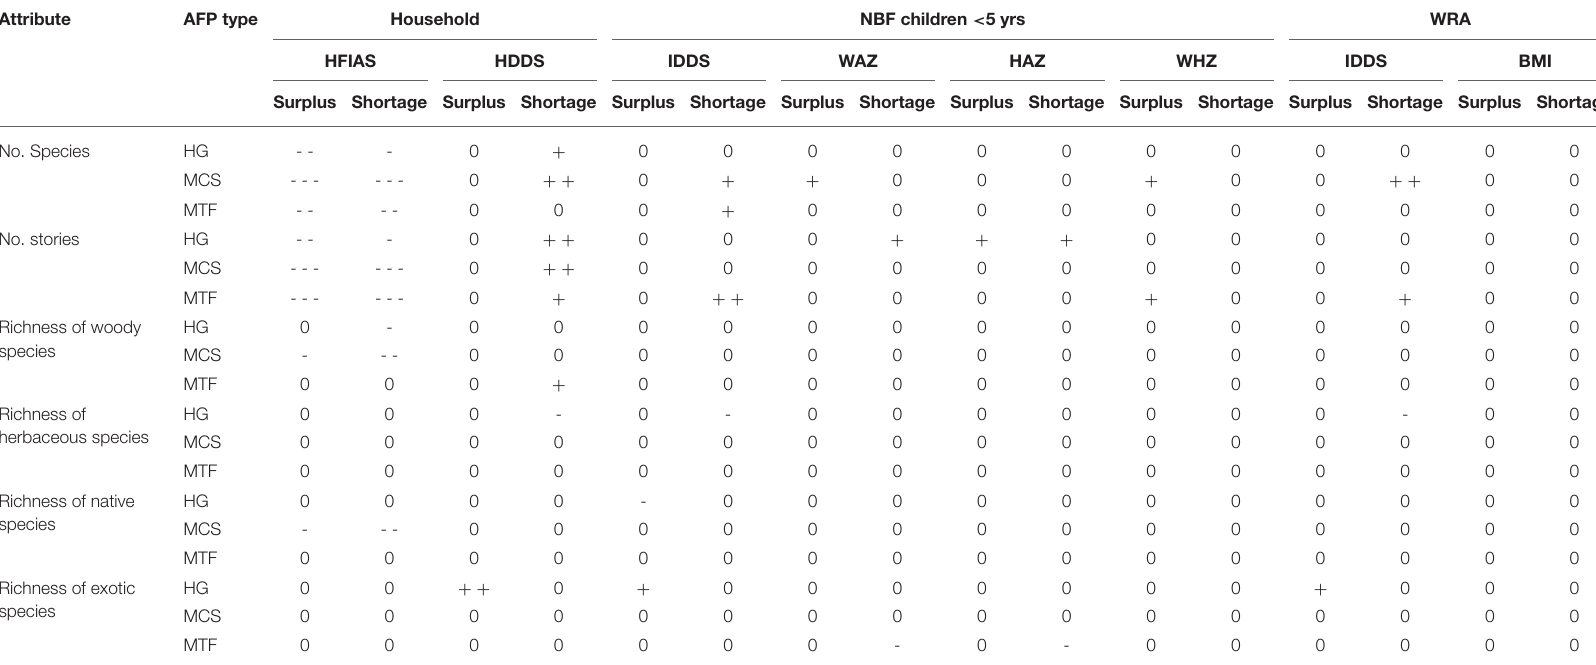
TABLE 1 | Pearson correlation among the attributes of three dominant agroforestry practices against food and nutrition security indices of two sensitive groups of rural smallholders in in Yayu during shortage and surplus seasons.